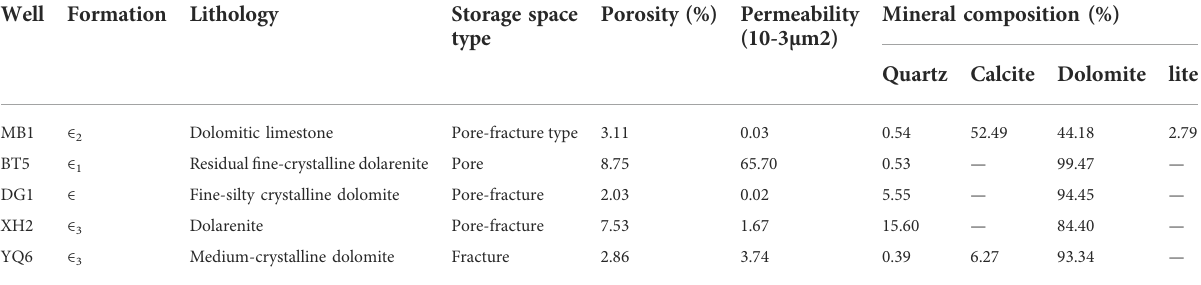
TABLE 1 Data of porosity, permeability, and mineral of experimental samples. Well Formation